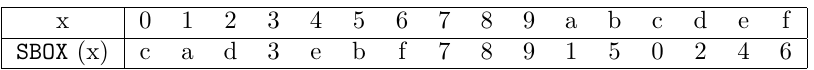
Table 2: 4-bit S-box SBOX .